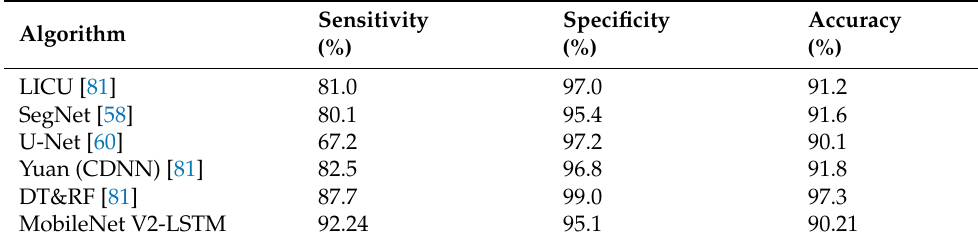
Table 4. The performances of the various algorithms.